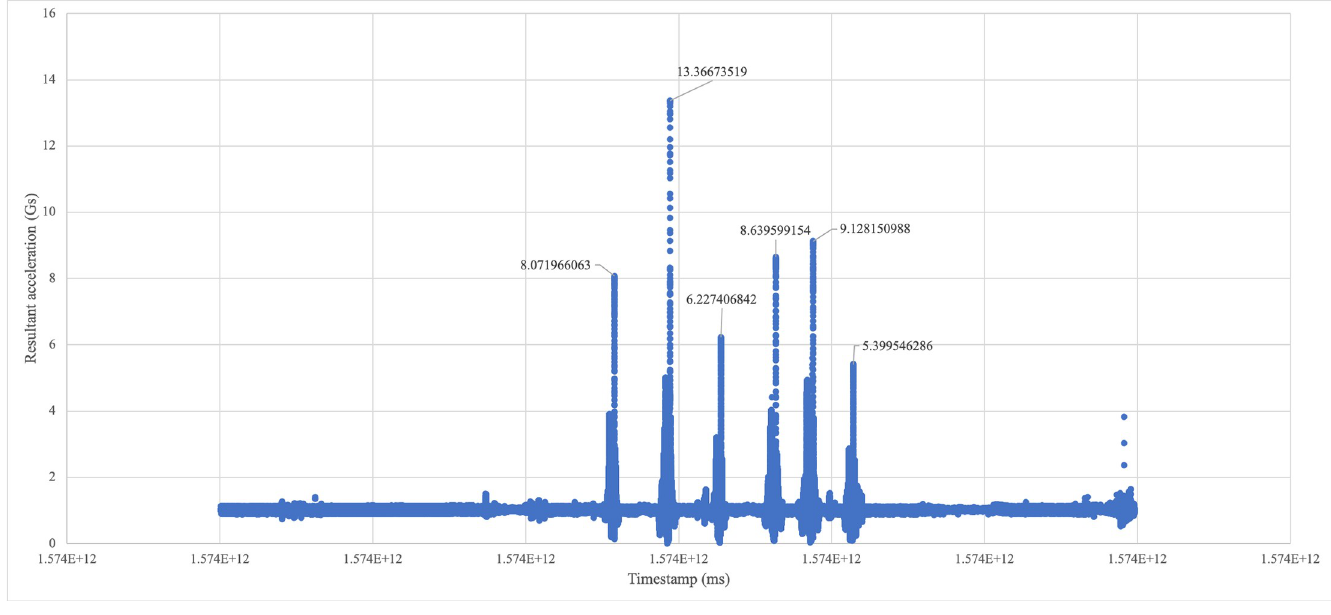
PLOS ONE | https://doi.org/10.1371/journal.pone.0245299 January 22,